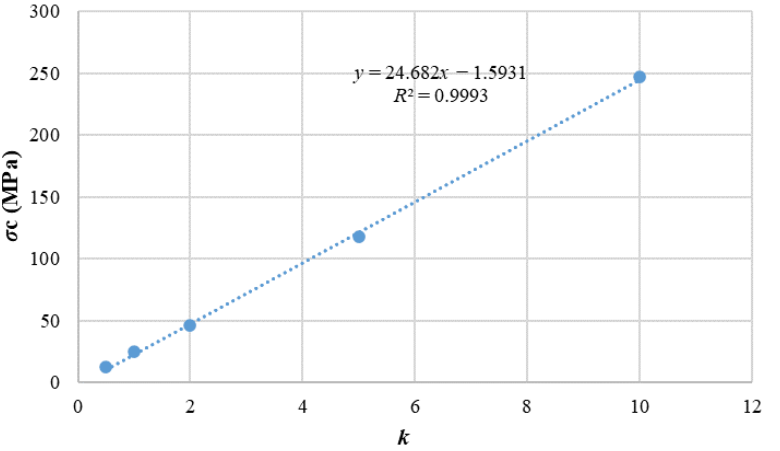
Figure 14. Fitting relationship between uniaxial compression magnification factor ratio and compressive strength.